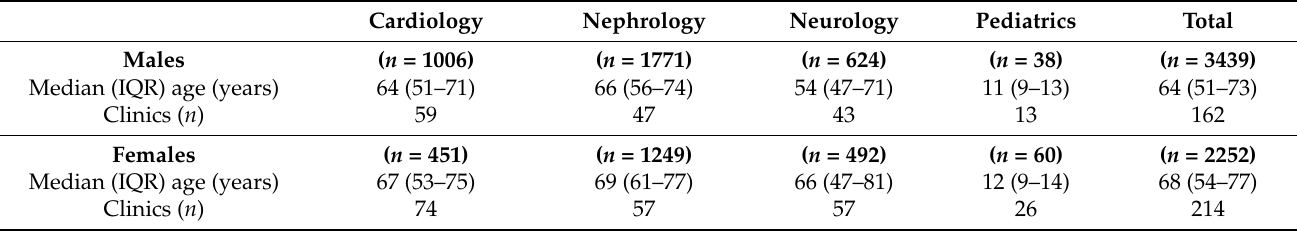
Table 1. Patients grouped according to the medical specialty of the referring